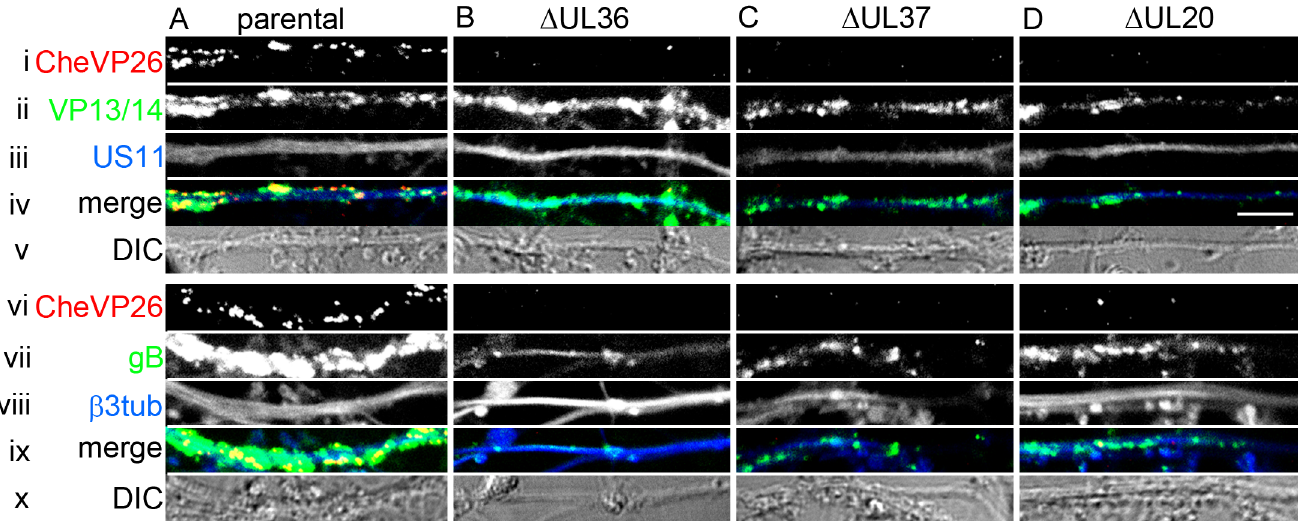
Fig 7. HSV1 outer tegument and envelope proteins are targeted to the axon independent of capsids. DRG neuronswere infected after 3 div with 1 x 10 7 pfu/mL of HSV1(17 + )Lox-CheVP26 (A), - Δ UL36(B), - Δ UL37(C), or - Δ UL20(D), fixed and permeabilized using the PHEMO protocol at 24 hpi, labeledwith antibodiesdirected againstVP13/14 (R220, ii), gB (R69, vi) or β -III-tubulin(mAb 5564, vii) and the axons were analyzedby confocal microscopy. CheVP26 (i and v), merge (iii and viii), differential interference contrast image (DIC, iv and ix). Scale bar is 5 μ m.